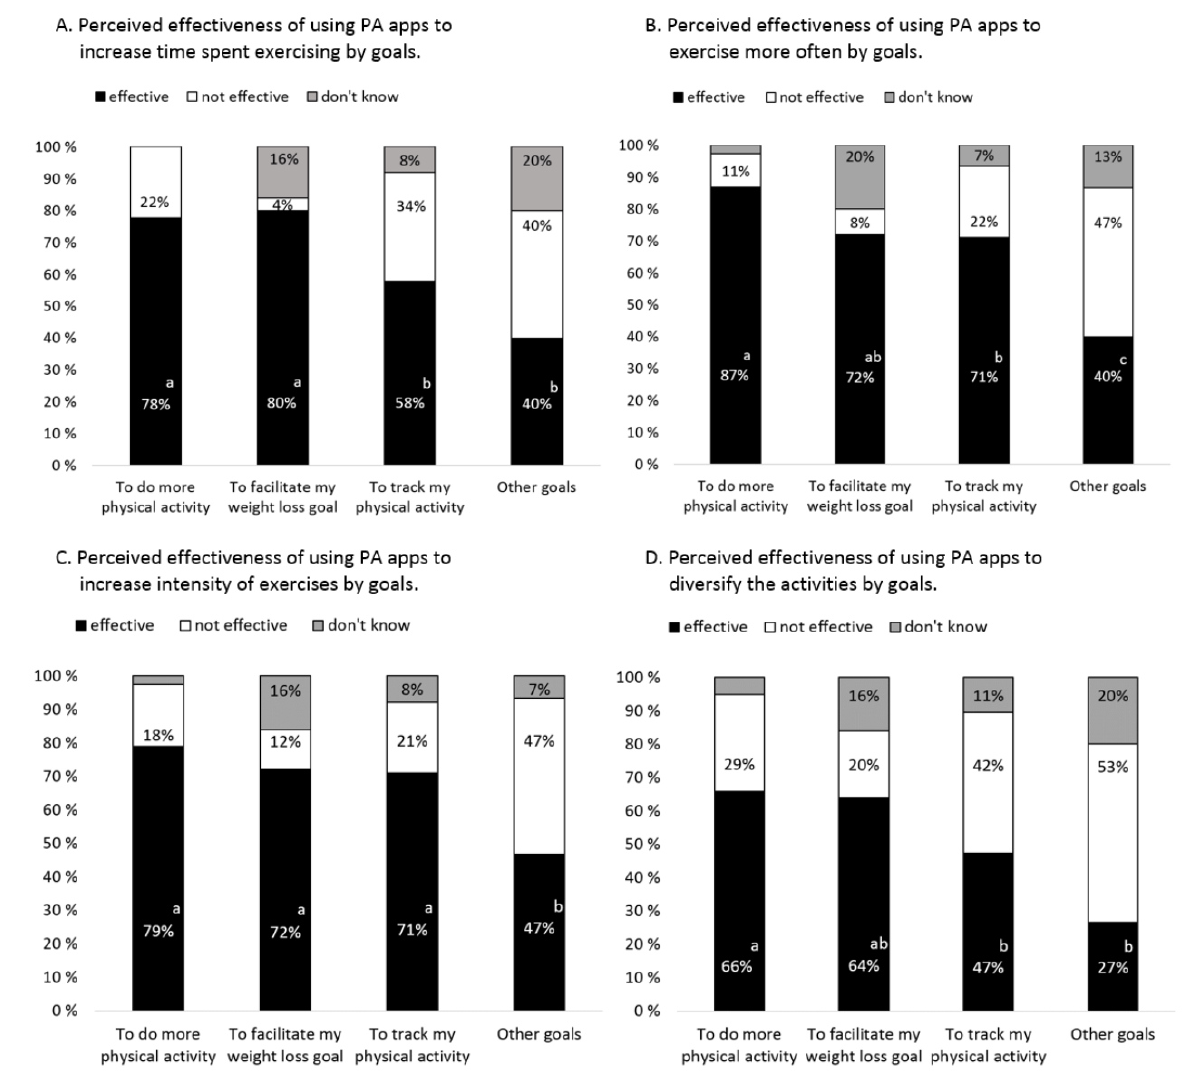
Figure 3. Percentages of PA app users with different goals and their evaluation of the effectiveness of using PA apps to assist their physical